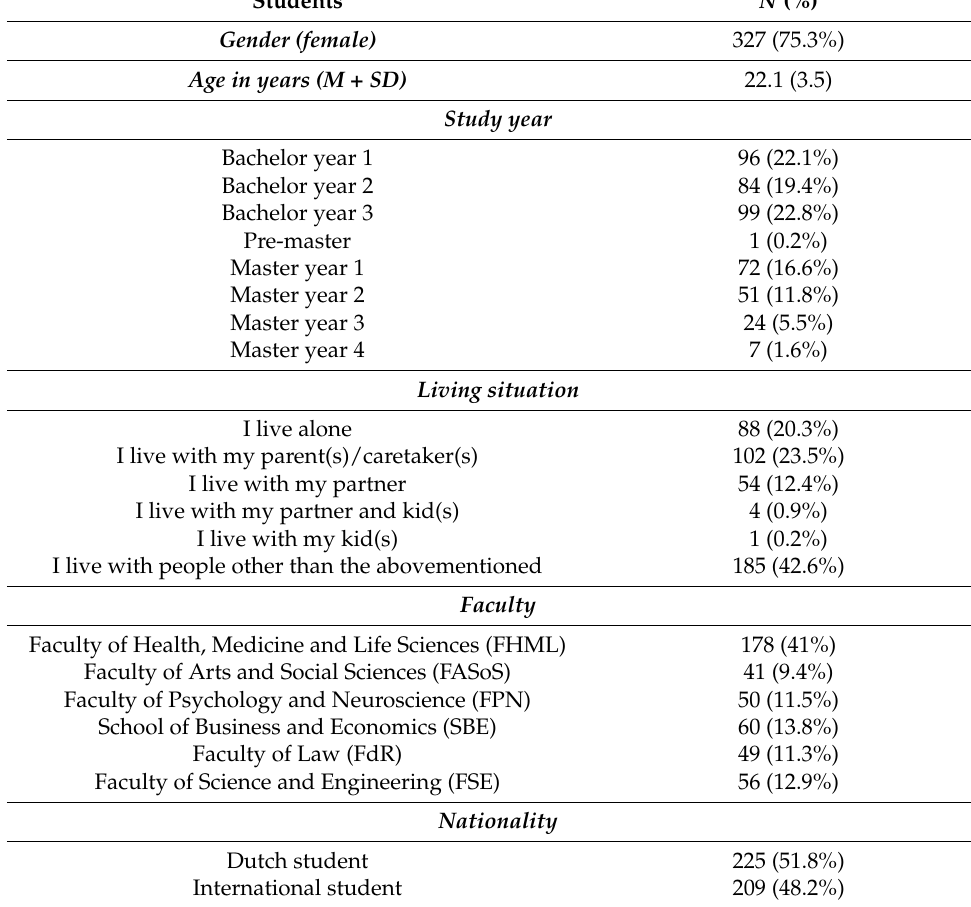
Table 1. Background characteristics of the sample ( N =